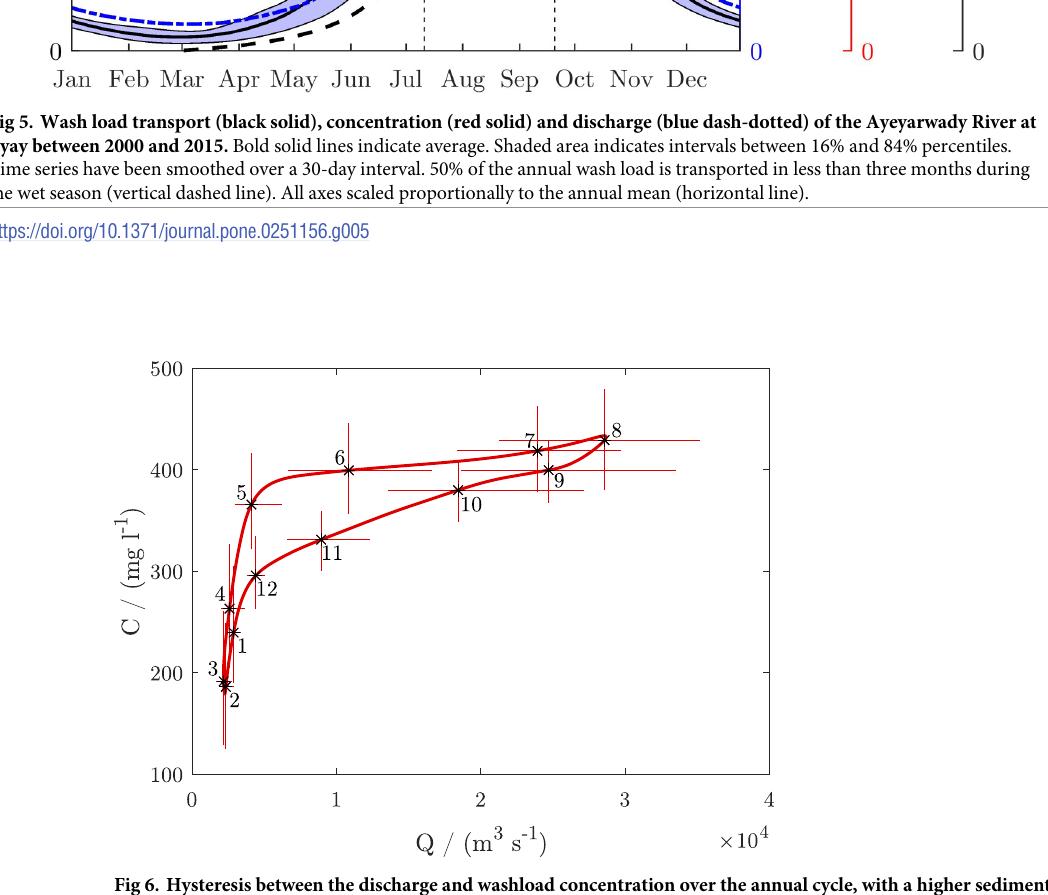
PLOS ONE | https://doi.org/10.1371/journal.pone.0251156 May 13,